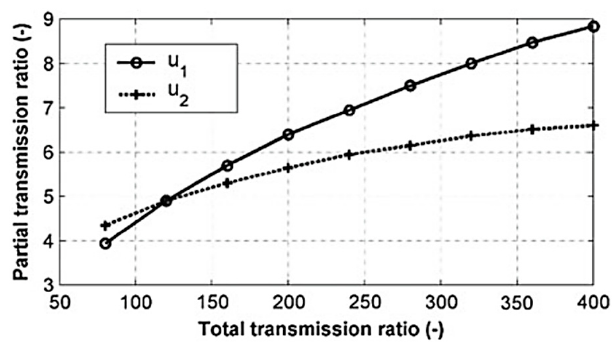
Figure 2. Partial gear ratios versus total gearbox ratio.